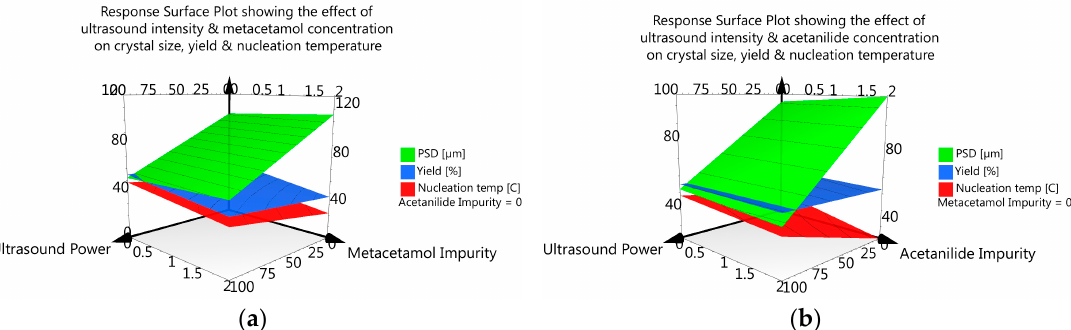
Figure 12. Respond surface plot showing the effect of ultrasound intensity, metacetamol ( a ) and acetanilide ( b ) concentration on crystal size, yield and nucleation temperature.